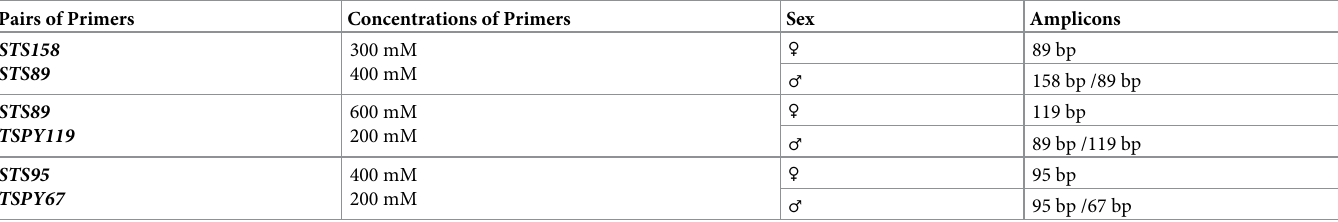
Table 3. Pairs of primers used in qPCR-duplex. Optimal concentrations and expected amplicons in both sexes are reported for the various primers. Pairs of